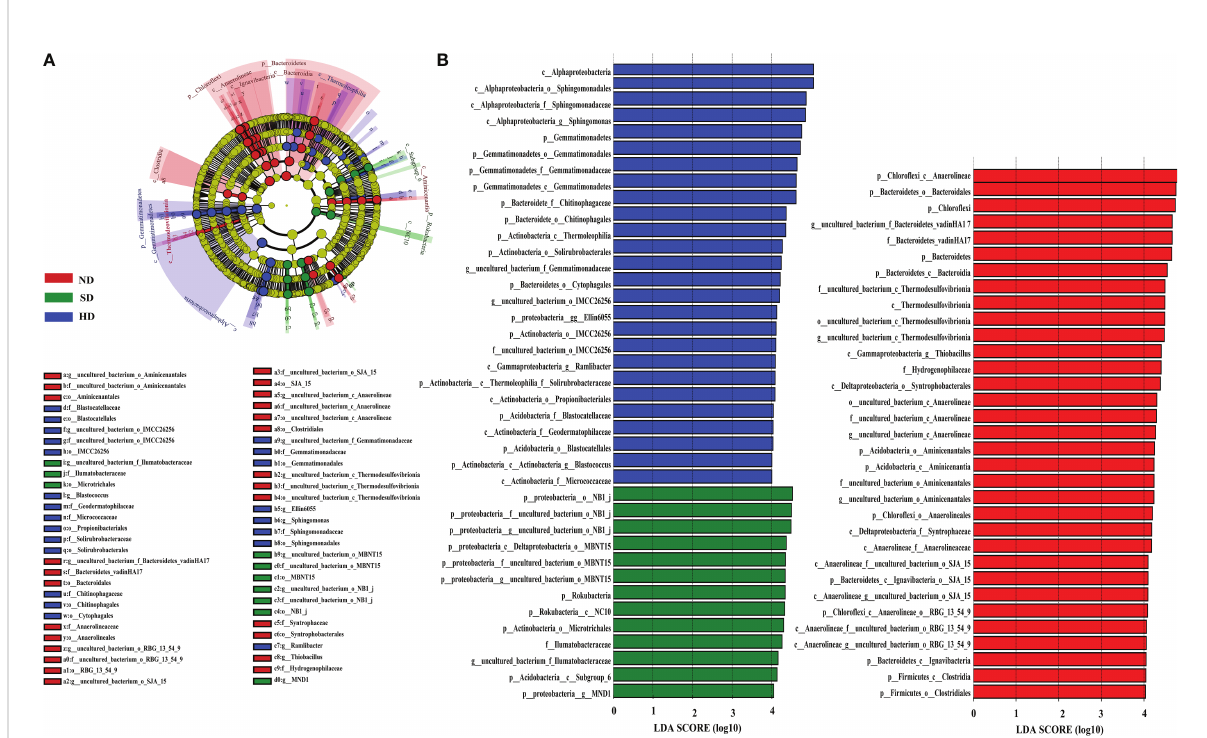
FIGURE 5 LEfSe analysis of the Bacterial abundance in the non-degraded (ND), slightly degraded (SD), and heavily degraded (HD) alpine wetland areas. (A) Phylogenetic tree with the ND, SD and HD bacterial biomarkers obtained with LEfSe analysis. (B) Histogram of the LDA scores computed for the differentially abundant bacteriaamong the degraded alpine wetlands identi fi ed with a threshold value of 4.0. Note: The LEfSe analysis was performed at the phylum to genus